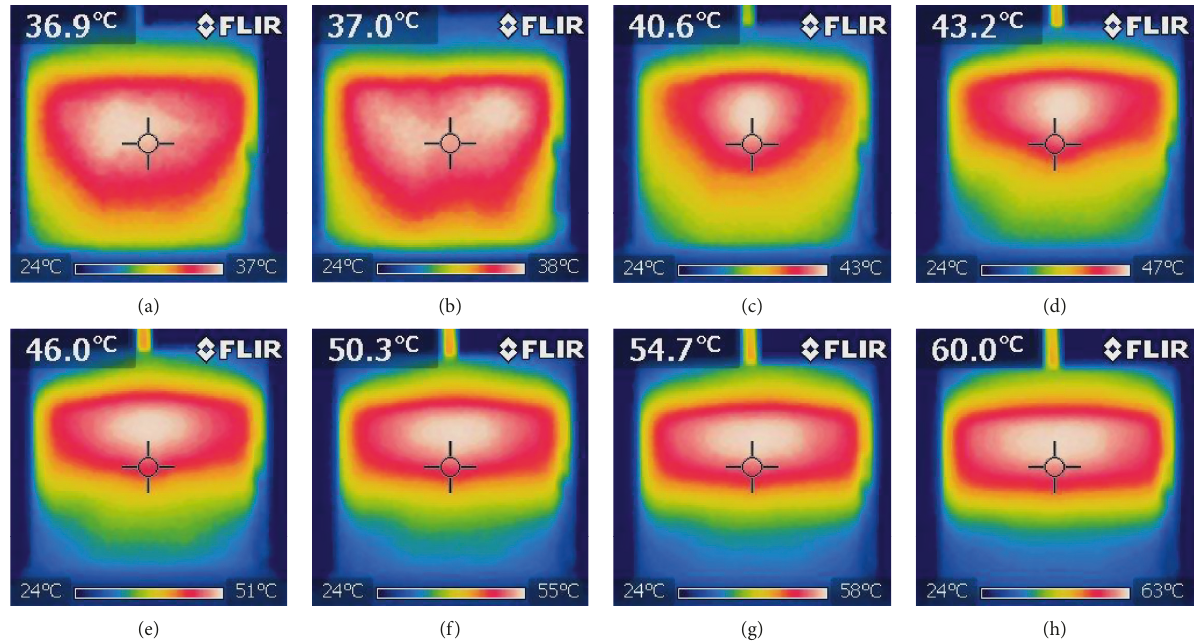
Figure 7: Temperature changes over time on the liver phantom: (a) start, (b) 30sec, (c) 60sec, (d) 90sec, (e) 120sec, (f) 150sec, (g) 180sec, and (h) 210sec in the case of antenna without the helical slot.